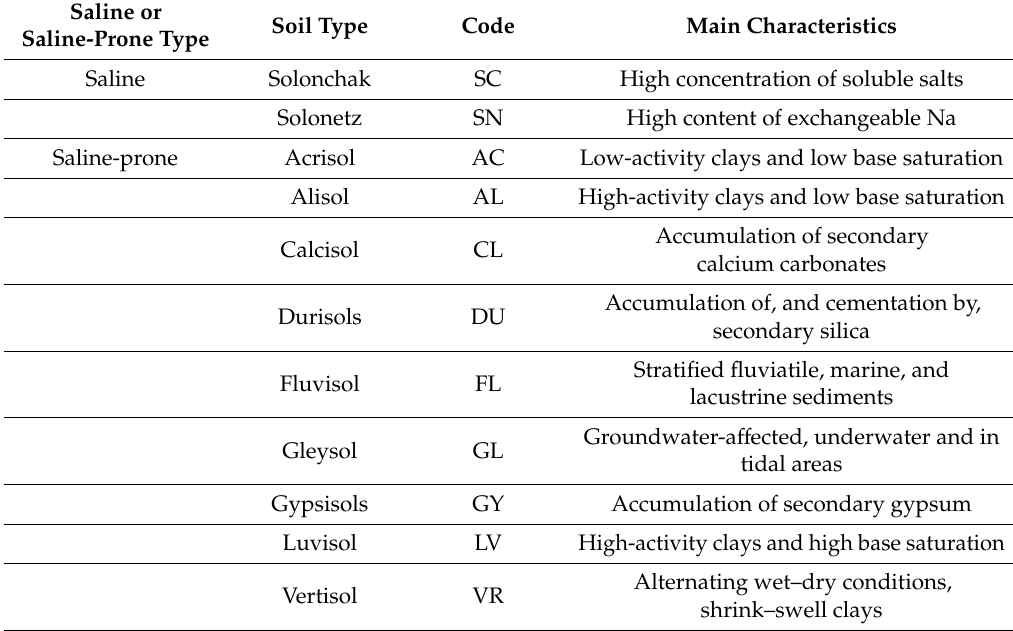
Table 2. Saline soils and saline-prone soils, and their main characteristics, according to the World Reference Base [46] (adapted from